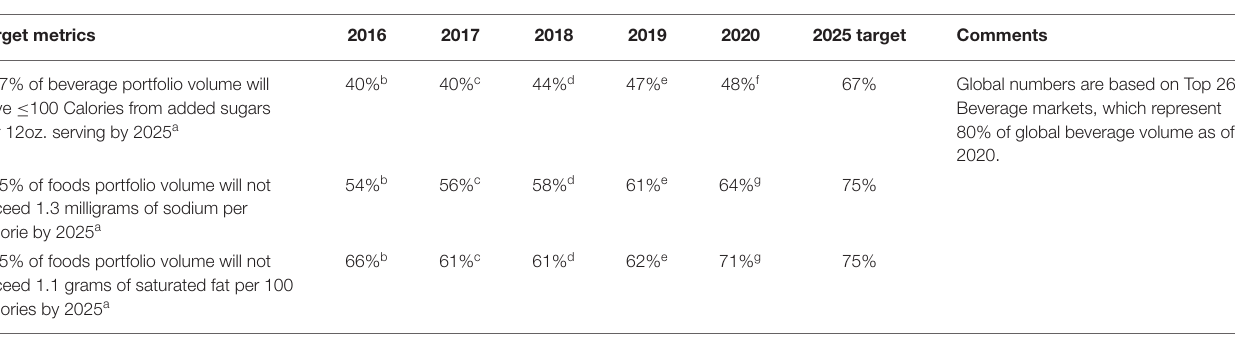
TABLE 6 | Results of category criteria